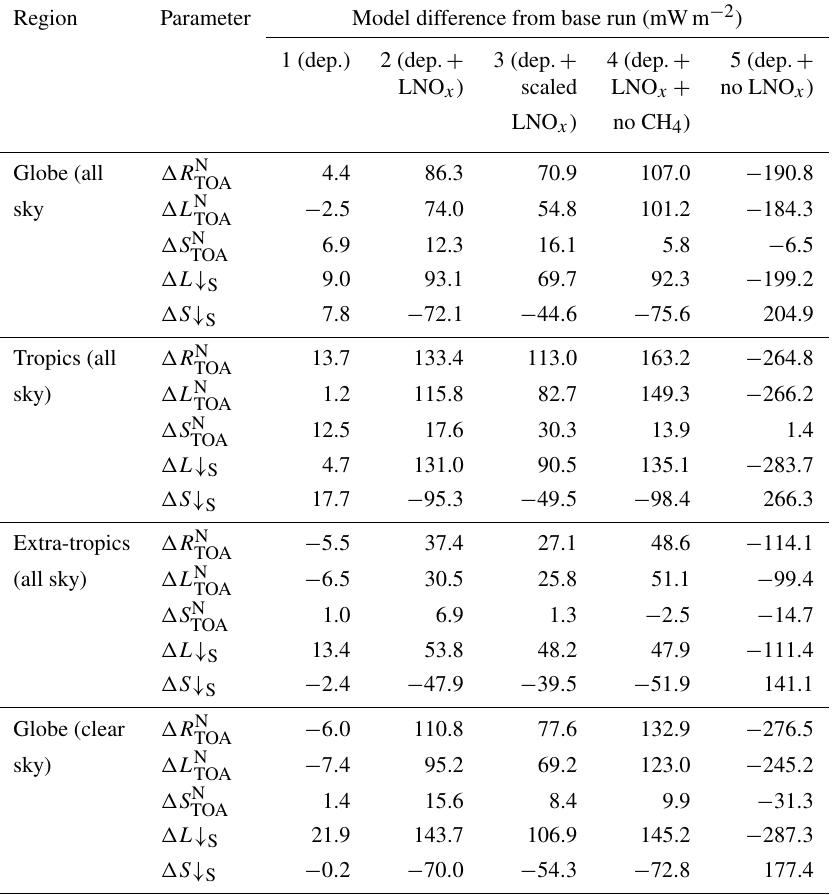
Table 4. Changes in the modelled net downward total TOA radiative flux ( (cid:49)R N net downward TOA shortwave radiative flux ( (cid:49)S N surface, with respect to the base model run. Values (mWm − 2 ) are averages over